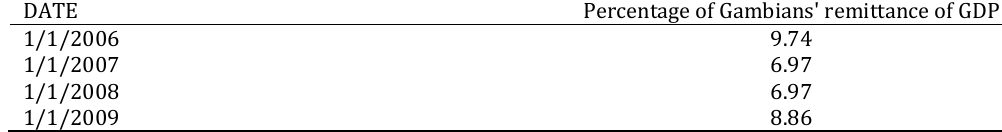
Table: Percentage of remittance inflows to GDP for Gambia DATE Percentage of Gambians' remittance of GDP 1/1/2006 9.74 1/1/2007